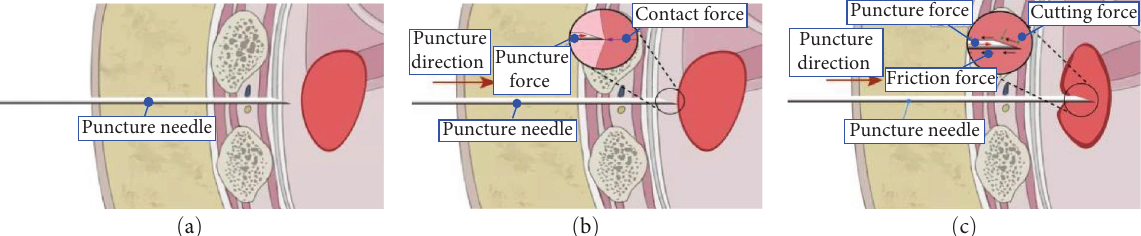
F IGURE 2: Diagram of puncture process: (a) the puncture needle is not in contact with the prostate soft tissue; (b) the puncture needle begins to contact with the prostate soft tissue; (c) the puncture needle enters the prostate soft tissue.